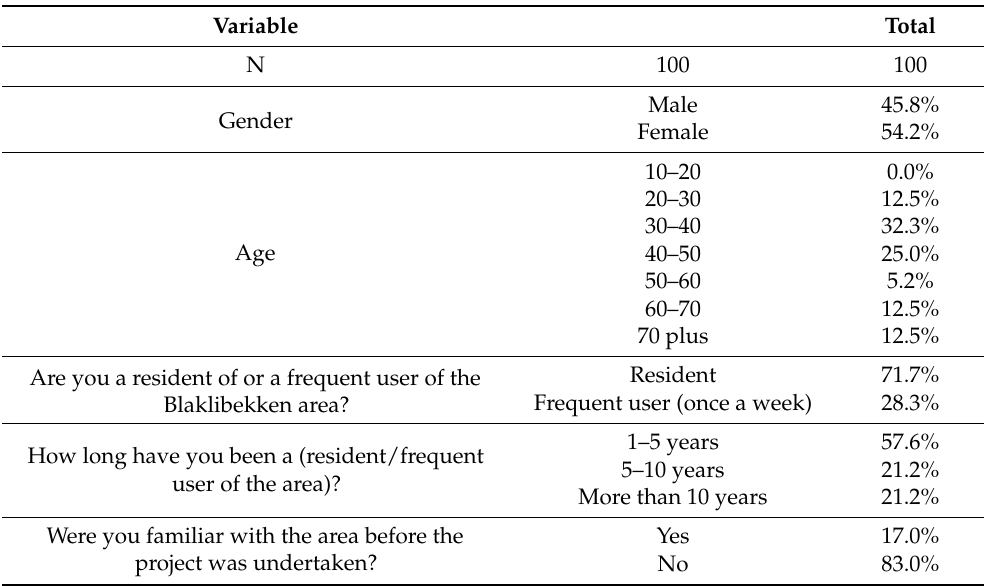
Table 1. Sample characteristics.